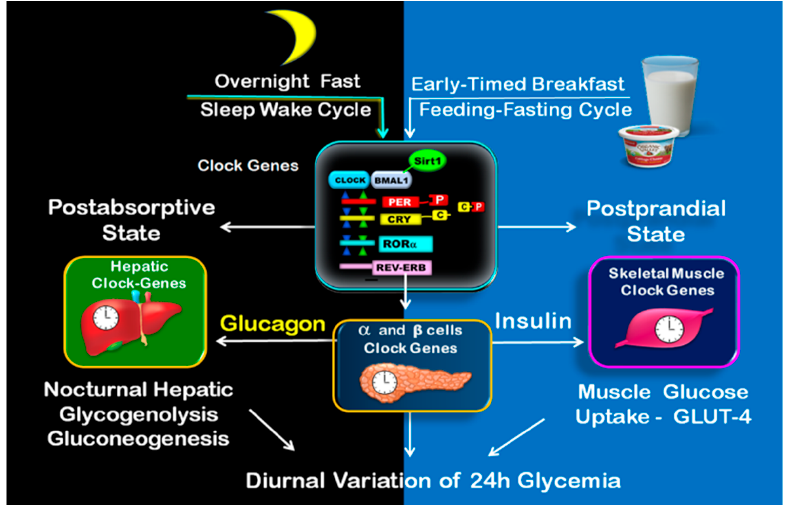
Figure 3. Clock-controlled postprandial and postabsorptive glucose metabolism. The illustration shows on the left side the clock-controlled glucose metabolism during overnight fast (postabsorptive state), consisting of nocturnal hepatic glycogenolysis and gluconeogenesis. The postprandial state is shown on the right side. It begins upon early-timed breakfast and consists mainly of muscle glucose uptake.